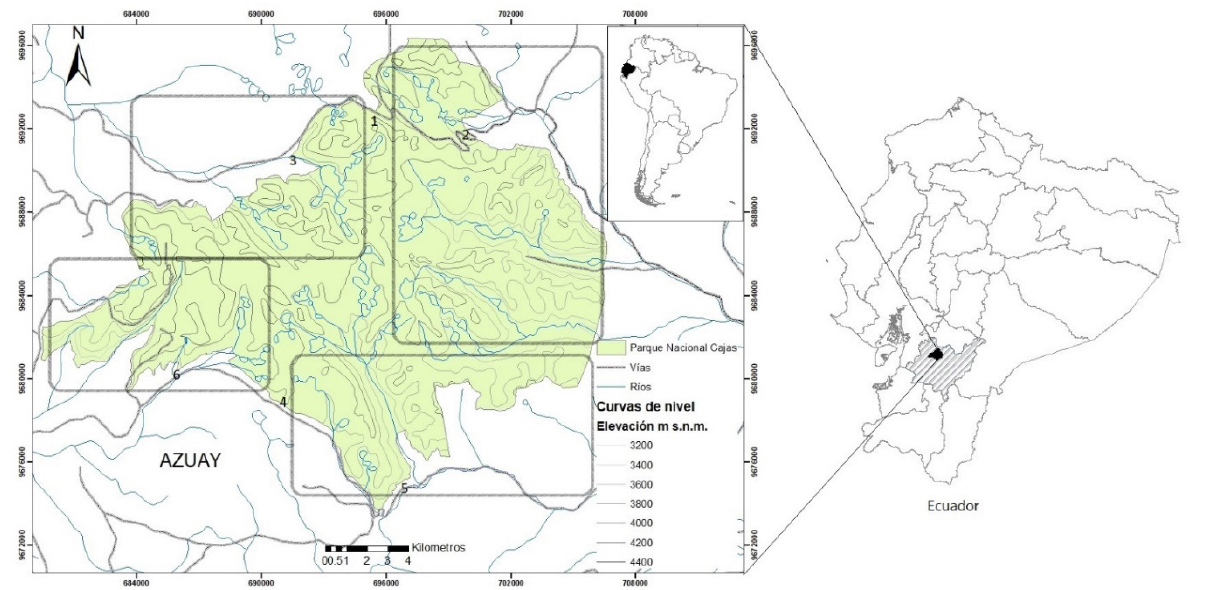
Figure 1. Location of the CNP. 1: Tres Cruces Pass (4270 m asl). 2: Quinuas River. 3: Migüir River. 4: Ruta de Soldados Pass (4080 m asl). 5: Yanuncay River. 6: Angas